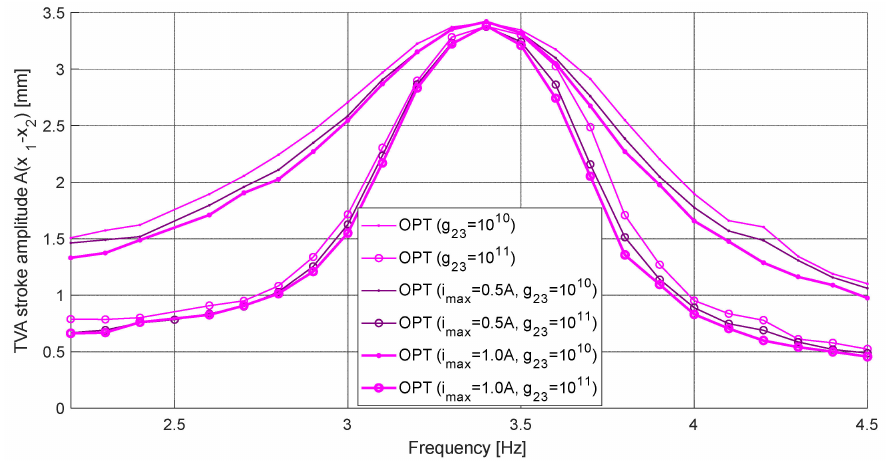
Figure 11. The TVA stroke amplitude A ( x 1 − x 2 ) frequency characteristics: OPT for different i max an d g 23 values, and F nom = 12.5 N.